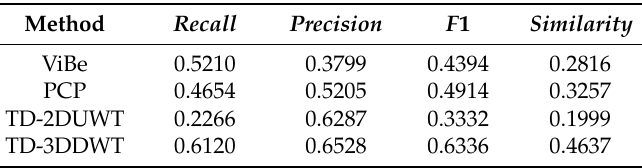
Table 4. Comparison of average metrics for